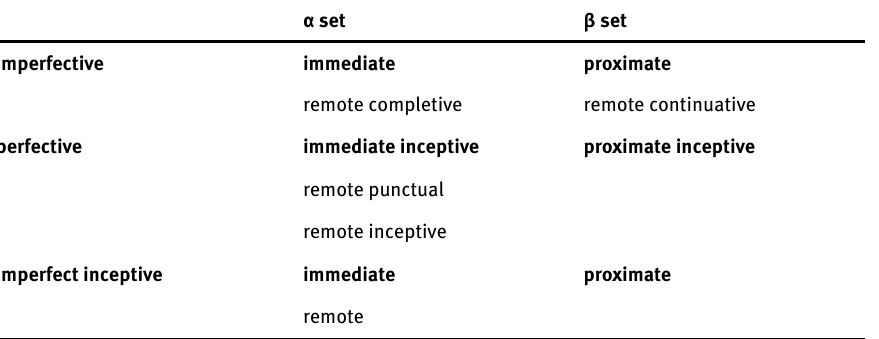
Table 13: Prefix sets for various tense/aspect categories